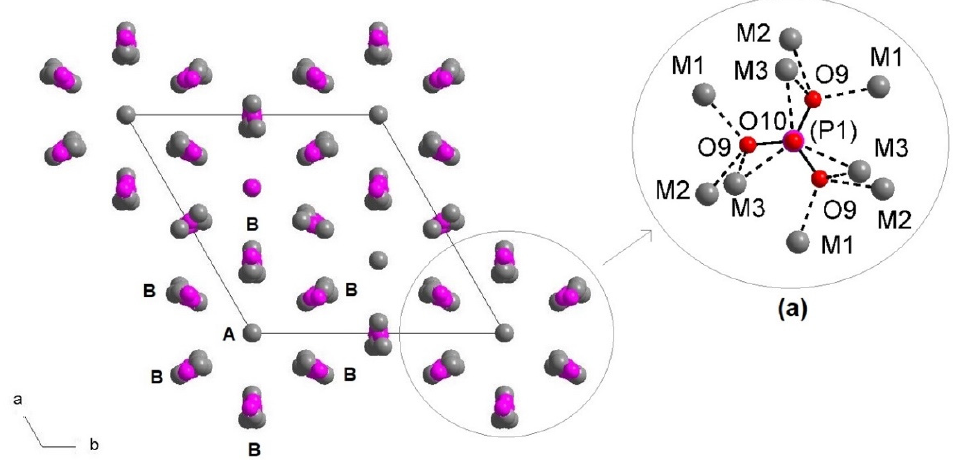
Figure 6. View down c of the RE β –TCP framework. Inset ( a ): (P1O 4 ) group environment and joining mechanisms with M1-M2-M3 polyhedra from adjacent B